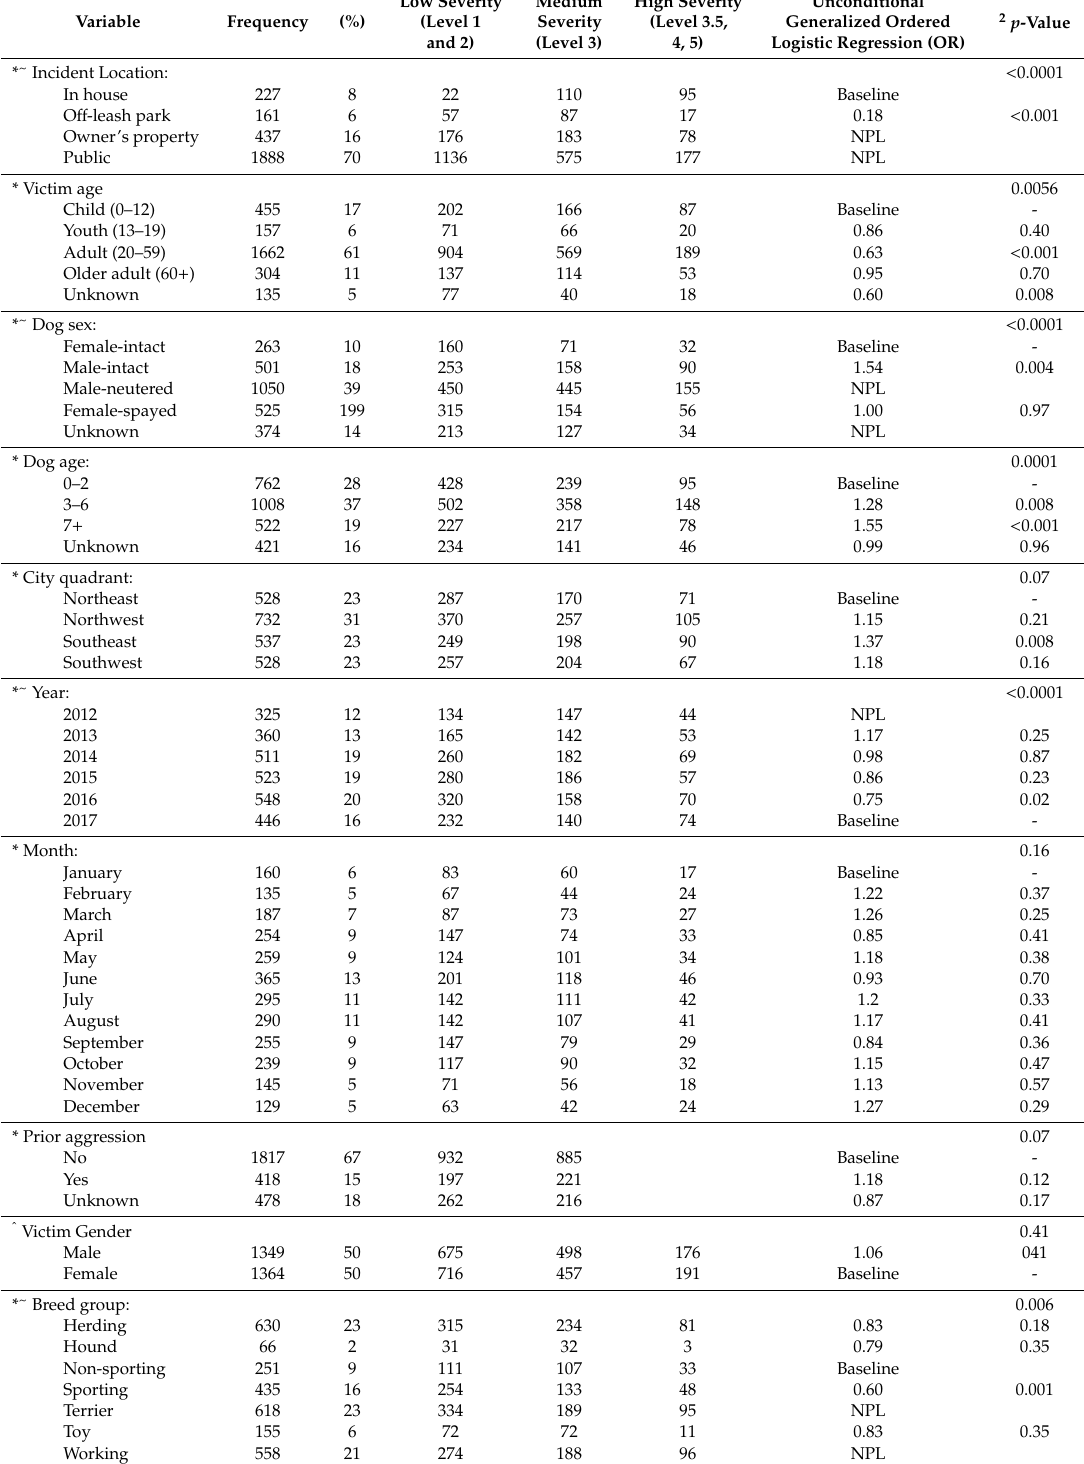
Table 2. The distribution and unconditional generalized ordered logistic regression odds ratio and p -value for each variable considered for inclusion in the final